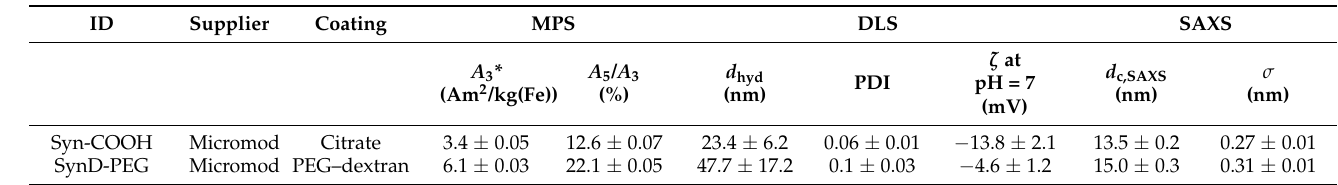
Table 1. Summary of the two different MNP systems used in this work. Given are the name and ID used in the graphs and text, together with the name of the supplier and coating of the MNP. Furthermore, the hydrodynamic diameter ( d hyd (z-average)), polydispersity index (PDI), and zeta potential ( ζ ) at a pH of 7, obtained by DLS and the characteristic MPS parameters ( A 3 *) ( A 3 normalized to iron amount, and shape parameter A 5 / A 3 as determined for the stock suspension) are presented. The MPS measurements were performed at B = 12 mT. The MPS noise level for the iron amount (determined from the magnetic moment amplitude with 5 × 10 − 11 Am 2 ) was determined as the iron mass of an MNP sample corresponding to where the MPS noise level was defined as the mean + 3xstandard deviation of A 3 resulting from 40 blank measurements after correction for the empty sample